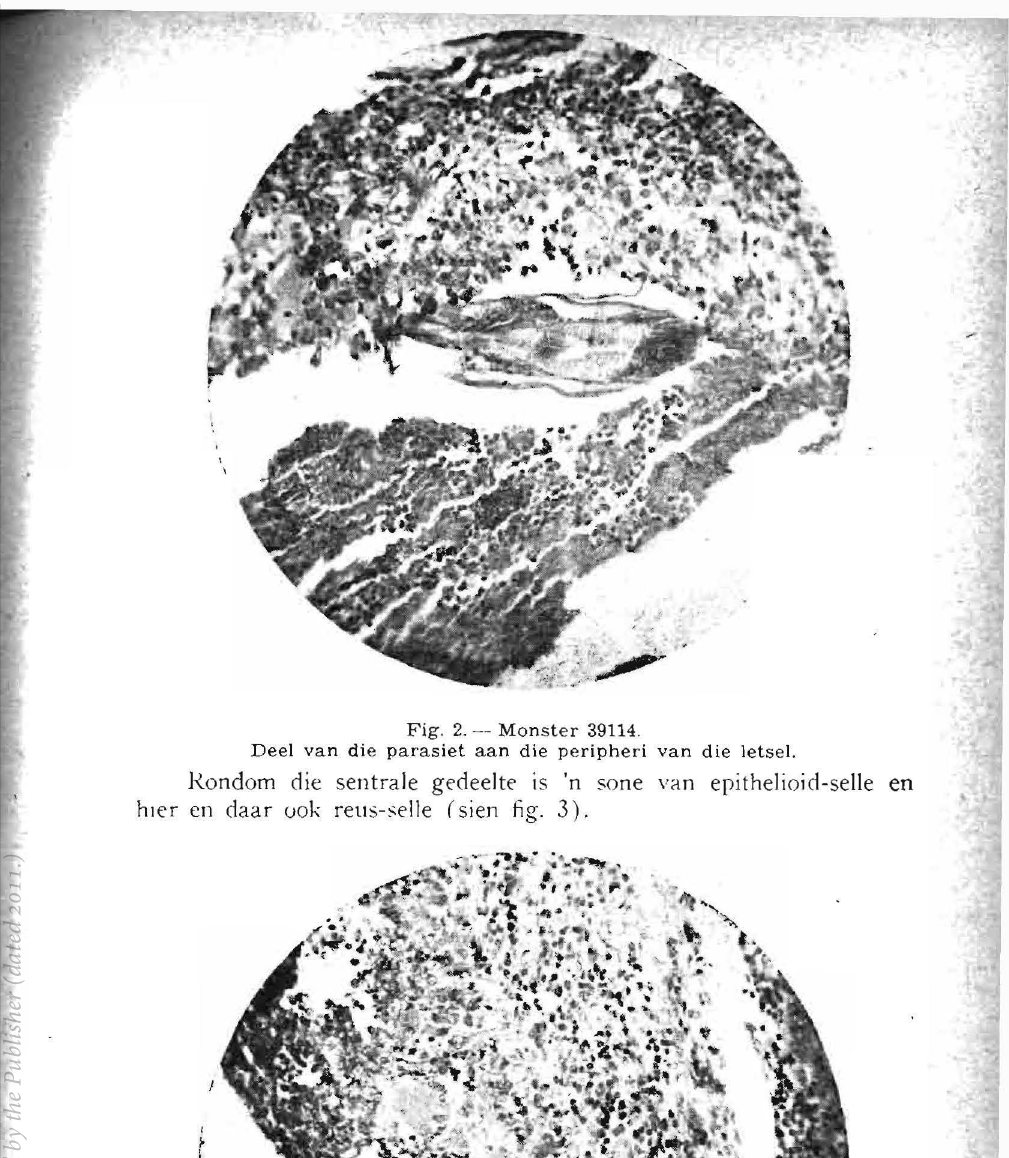
Fig. 3. - Monster 39114. So os fig. 1. -